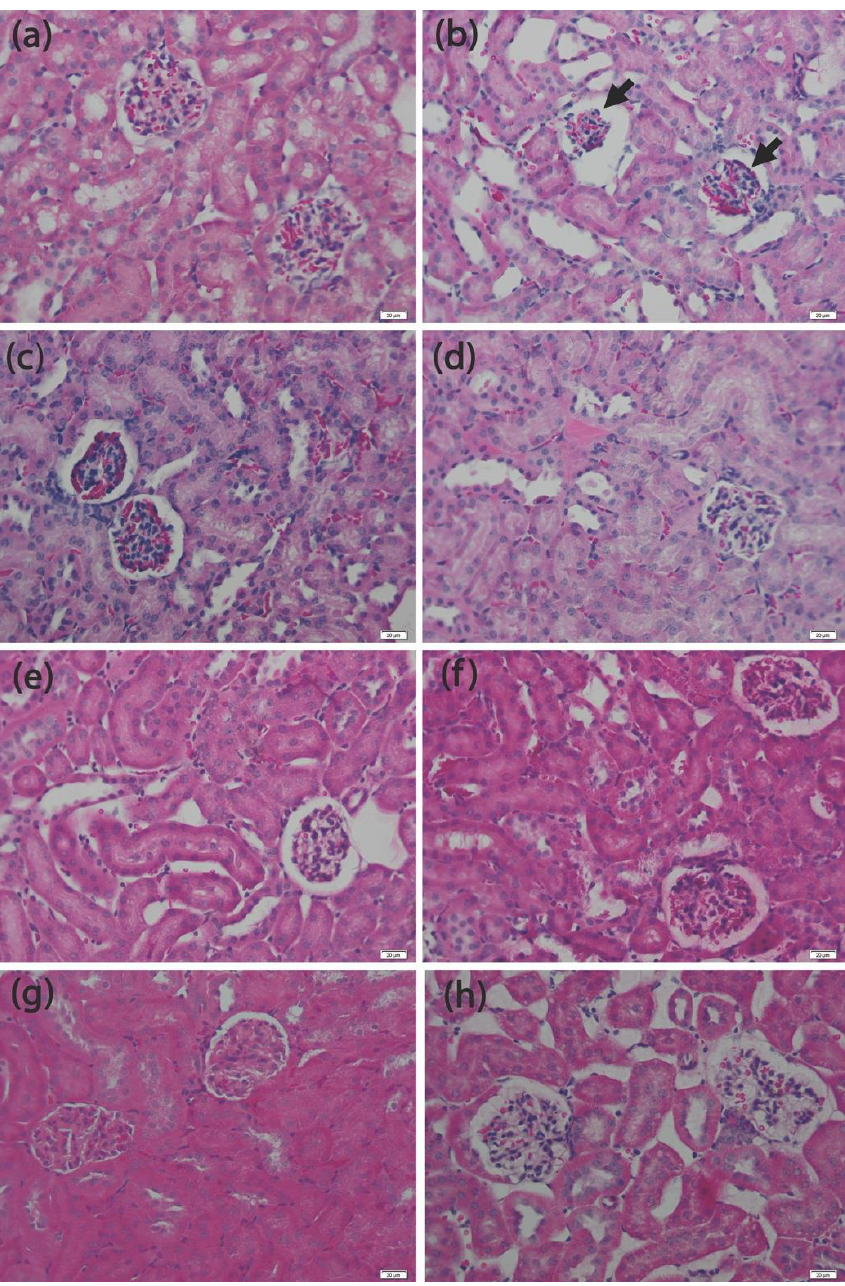
Figure 4. Histopathological sections of kidney of the experimental groups, H&E × 200. Various degrees of histopathological changes were observed in Cd exposure groups, mainly including glomerular atrophy (arrow) and tubular damage ( b ). Co-administration of SeNPs with Cd, reduced the metal toxic histological changes in the kidney in dose dependent manner, more obvious for LSeNPs. CV-centrilobular vein. Groups: Control ( a )-mice received only water; Cadmium group ( b )-mice received orally 5 mg/kg CdCl 2 ; 0.1 SeNPs + Cd ( c ) (0.1 mg/kg SeNPs + 5 mg/kg CdCl 2 ); 0.2 SeNPs + Cd ( d ) (0.2 mg/kg SeNPs + 5 mg/kg CdCl 2 ); 0.4 SeNPs + Cd ( e ) (0.4 mg/kg SeNPs + 5 mg/kg CdCl 2 ); 0.1 LSeNPs + Cd ( f ) (0.1 mg/kg LSeNPs + 5 mg/kg CdCl 2 ); 0.2 LSeNPs + Cd ( g ) (0.2 mg/kg LSeNPs + 5 mg/kg CdCl 2 ); 0.4 LSeNPs + Cd ( h ) (0.4 mg/kg LSeNPs + 5 mg/kg CdCl 2